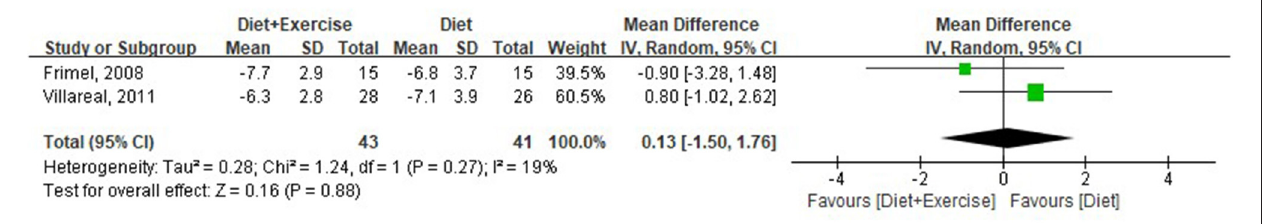
FIGURE 4 | Forest plot of the effects of dietary advice with or without exercise on fat